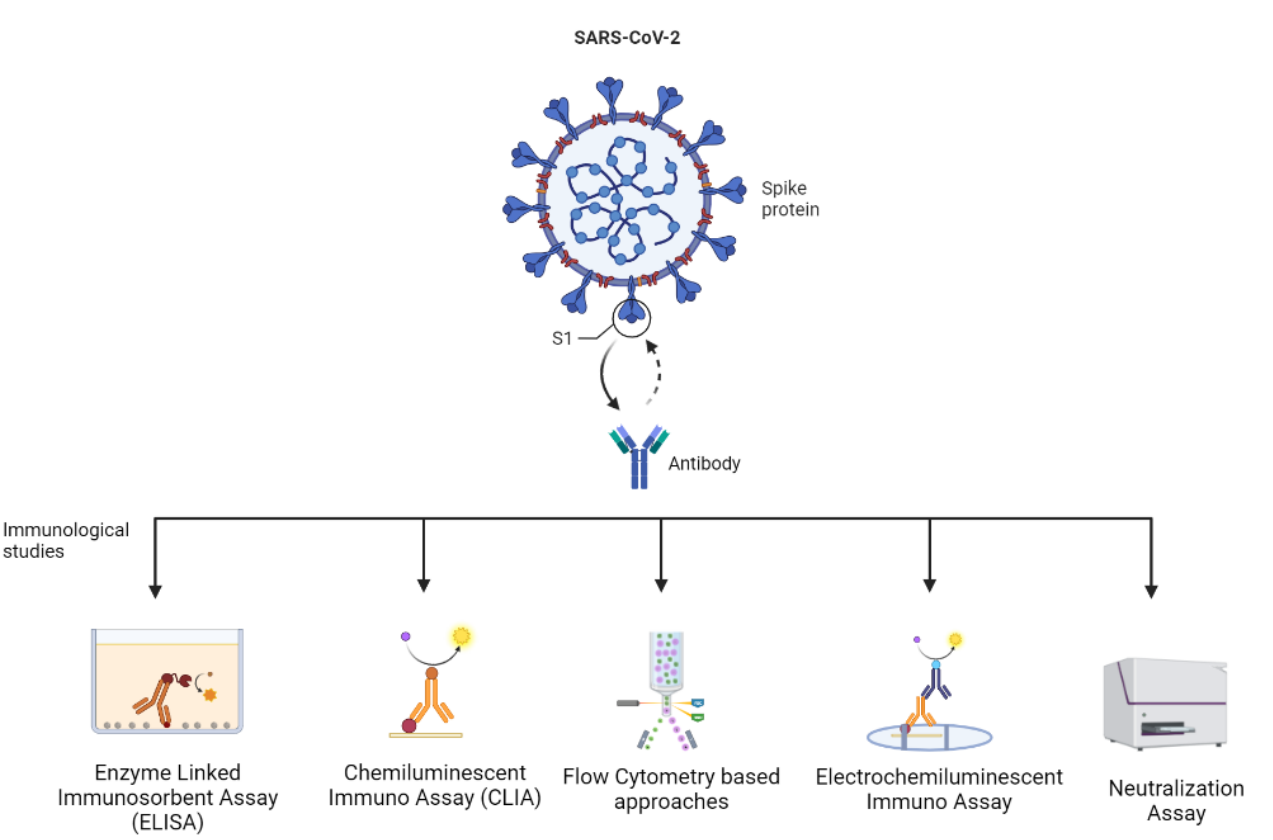
Figure 2. Different immunological assays to study hybrid variants (Created by BioRender.com) .